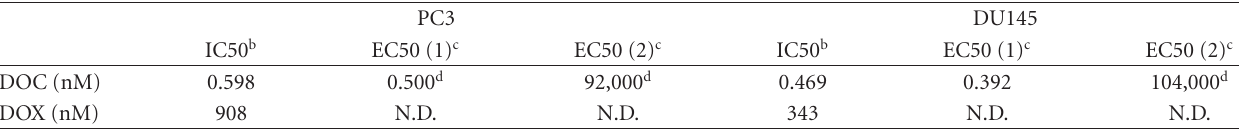
Table 1: Cytotoxicity of docetaxel (DOC) and doxorubicin (DOX) in hormone-refractory PC3 and DU145 cancer cell lines a . IC50 values are given as